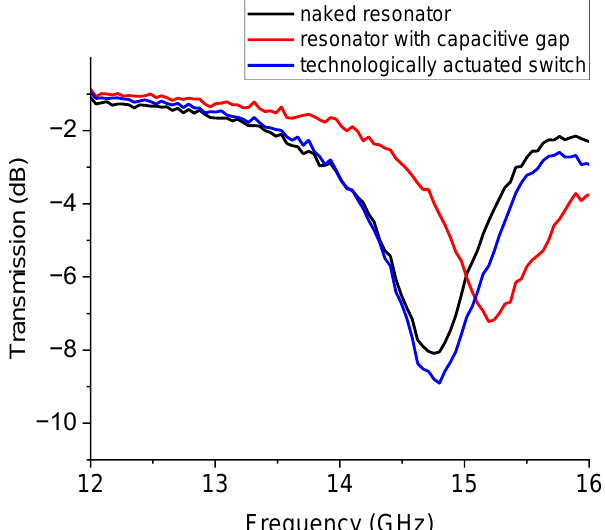
Figure 10. Experimental response of the U-shaped resonator for the 15 GHz operation. The black curve is for the U-resonator without a switch, and the blue curve is the response with the cantilever technologically actuated. The red curve is for the open switch, emulated by a capacitive gap.